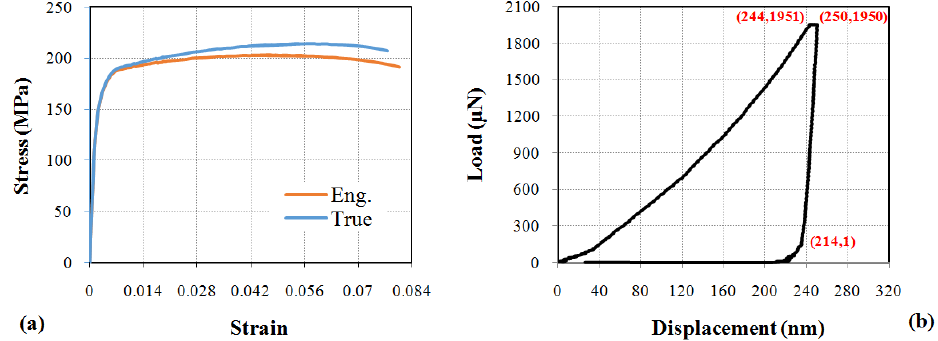
Figure 3. The stress–strain curve of the uniaxial tensile test ( a ), and the average load/unload-displacement curve for the nanoindentation experiment ( b ) of aluminum 1100.